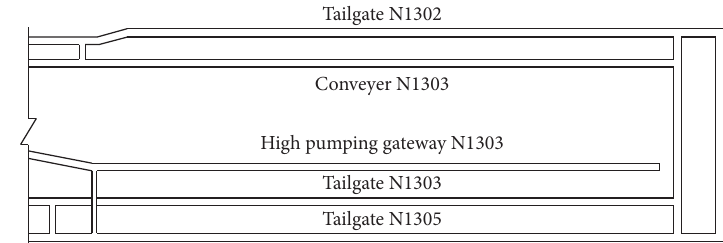
Figure 8: Gateway layout of N1303 working